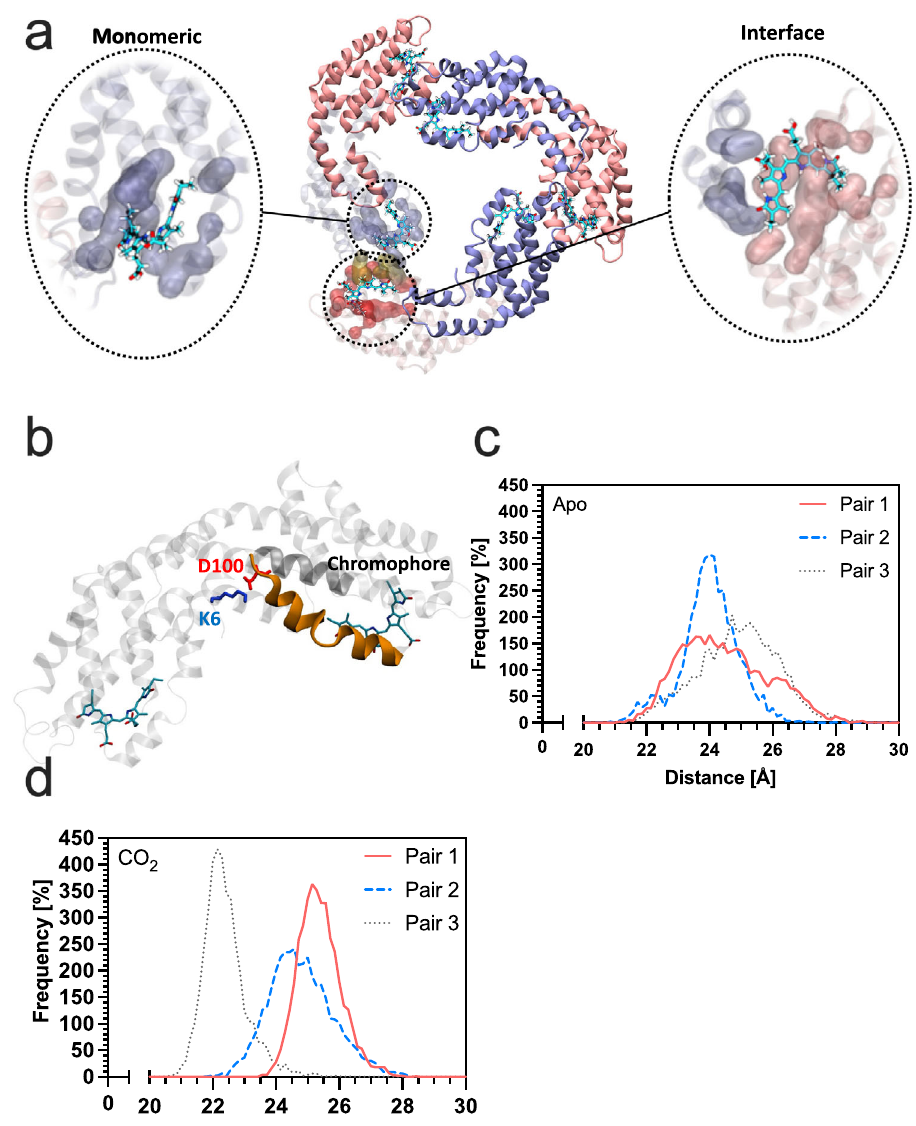
Fig. 3 | CO 2 alters pairwise chromophore interactions in allophycocyanin tri- mersfrom Thermosynechococcusvulcanus .a RibbondiagramoftheApcAB( αβ ) 3 trimerdemonstratingthemonomericandinterfacechromophore-bindingpockets. ApcAisshowninred and ApcBinblue. b K6forms asaltbridge withD100.D100is sited on an α -helixthatconnects tothechromophore-binding pocket. c Plotof